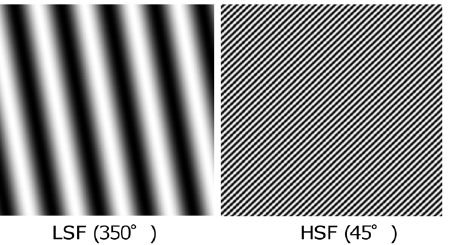
Figure 4. Sample stimuli from the SF grating manipulation task. The grating on the left is a LSF (global) grating with a 350 u tilt, whereas the one on the right is a HSF (local) grating with a 45 u tilt.